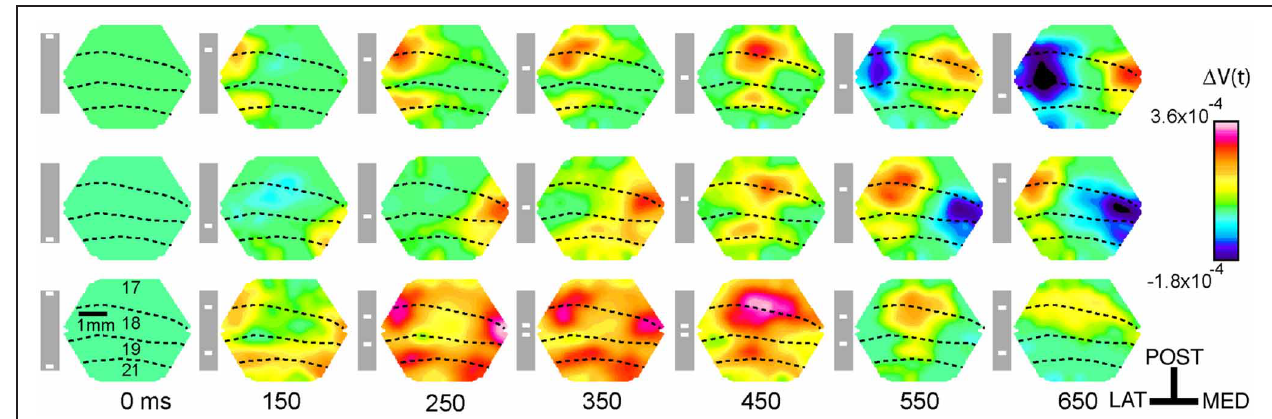
FIGURE 2 | Snapshots of the dye signal changes taken from the left hemisphere in one animal, for the three conditions (shown in the gray boxes). All (cid:3) V ( t ) increases at yellow scale and above were significant ( p < 0 . 01). As the photodiode array creates a mirror image of the cortex, lateral (LAT) is to the left and medial (MED) is to the right and posterior (POST) is up. Dashed lines show the cytoarchitectural borders of the animal. Time of the snapshots and bar position at the display screen shown in ms below each column. Note that the bar mapping on the cortex only corresponds to the maximal (cid:3) V ( t ) increase in the snapshot. For the occlusion condition (last row), the (cid:3) V ( t ) increase emerges in the cortex